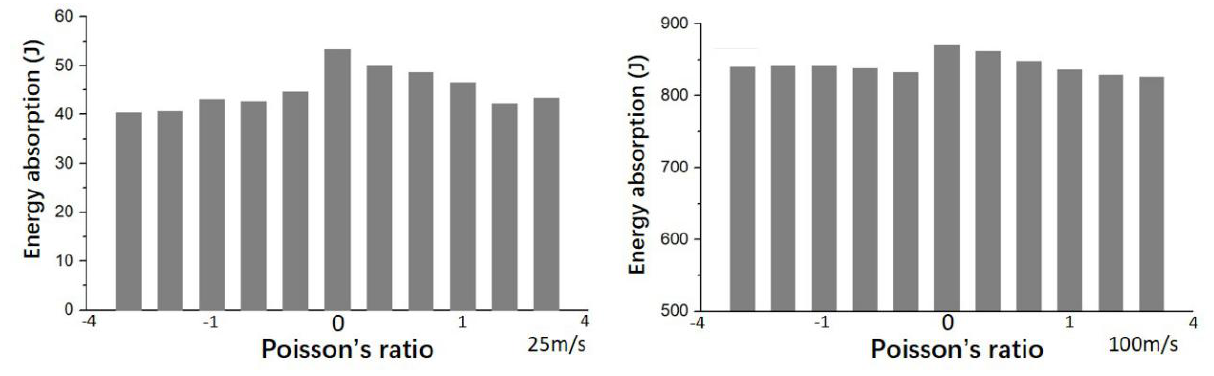
Figure 12: Energy absorption of sandwich panel with different Poisson’s ratios.